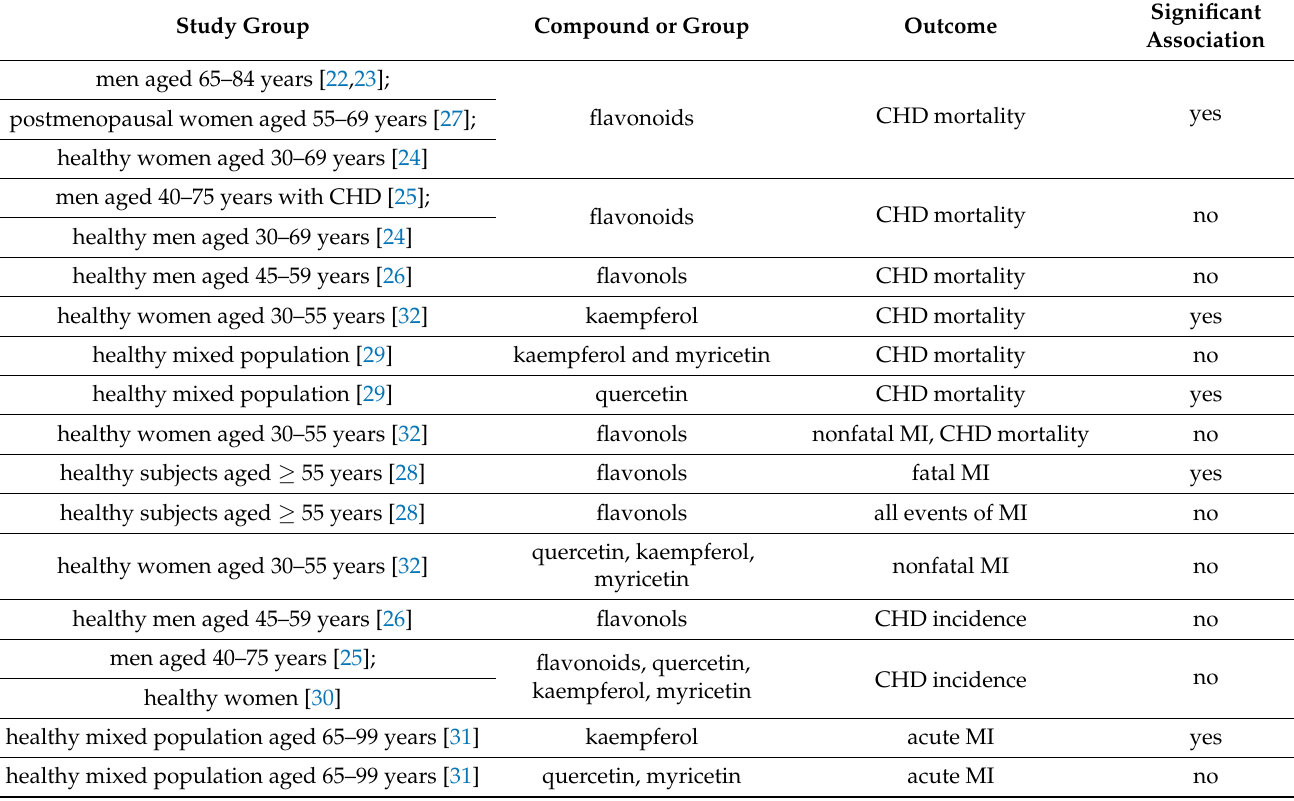
Table 1. The simplified summary of flavonols’ impact on CVD incidence and